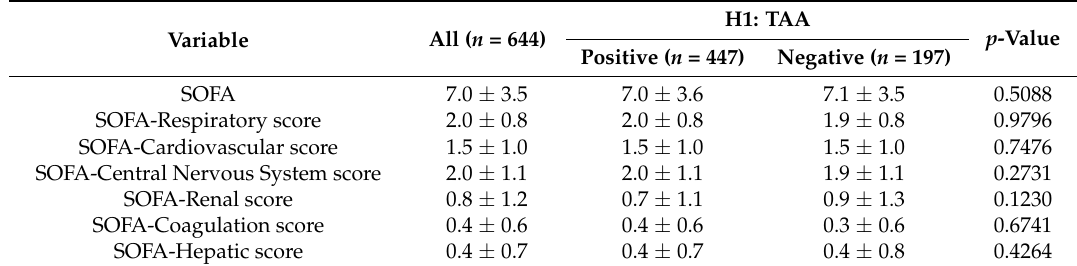
Table 7. Disease severity with regard to the CTLA-4 haplotype H1: